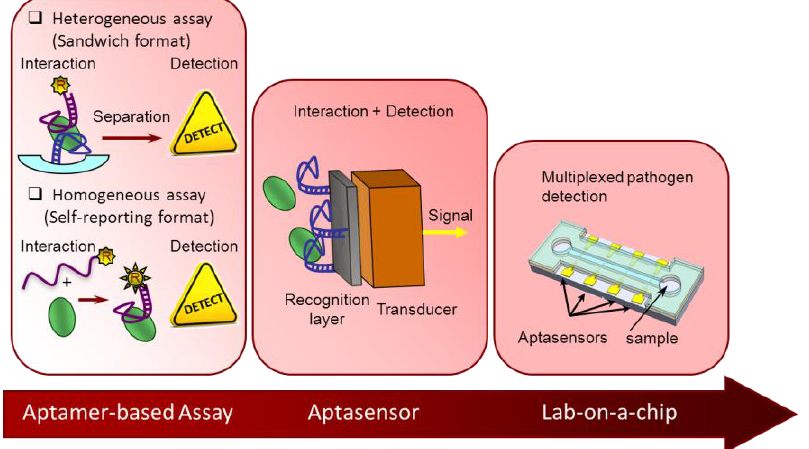
Figure 1. Schematic overview of the different approaches for aptasensing according to their level of